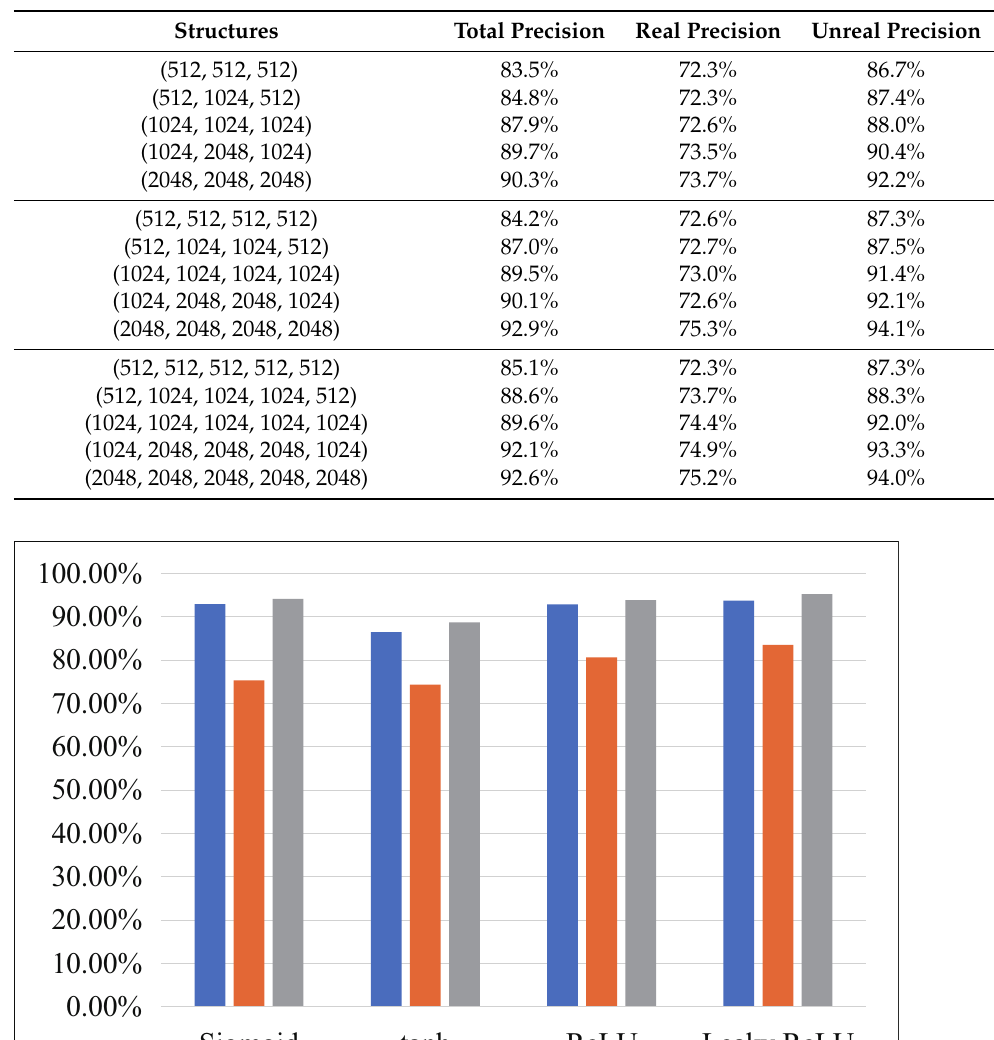
Table 4. Comparison of experiment results with different network structures.